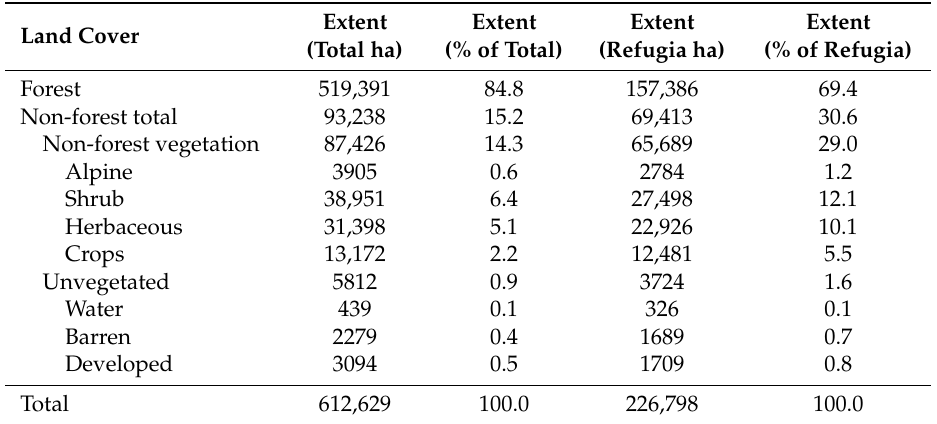
Table 1. Land cover types across study fires according to GAP analysis data.